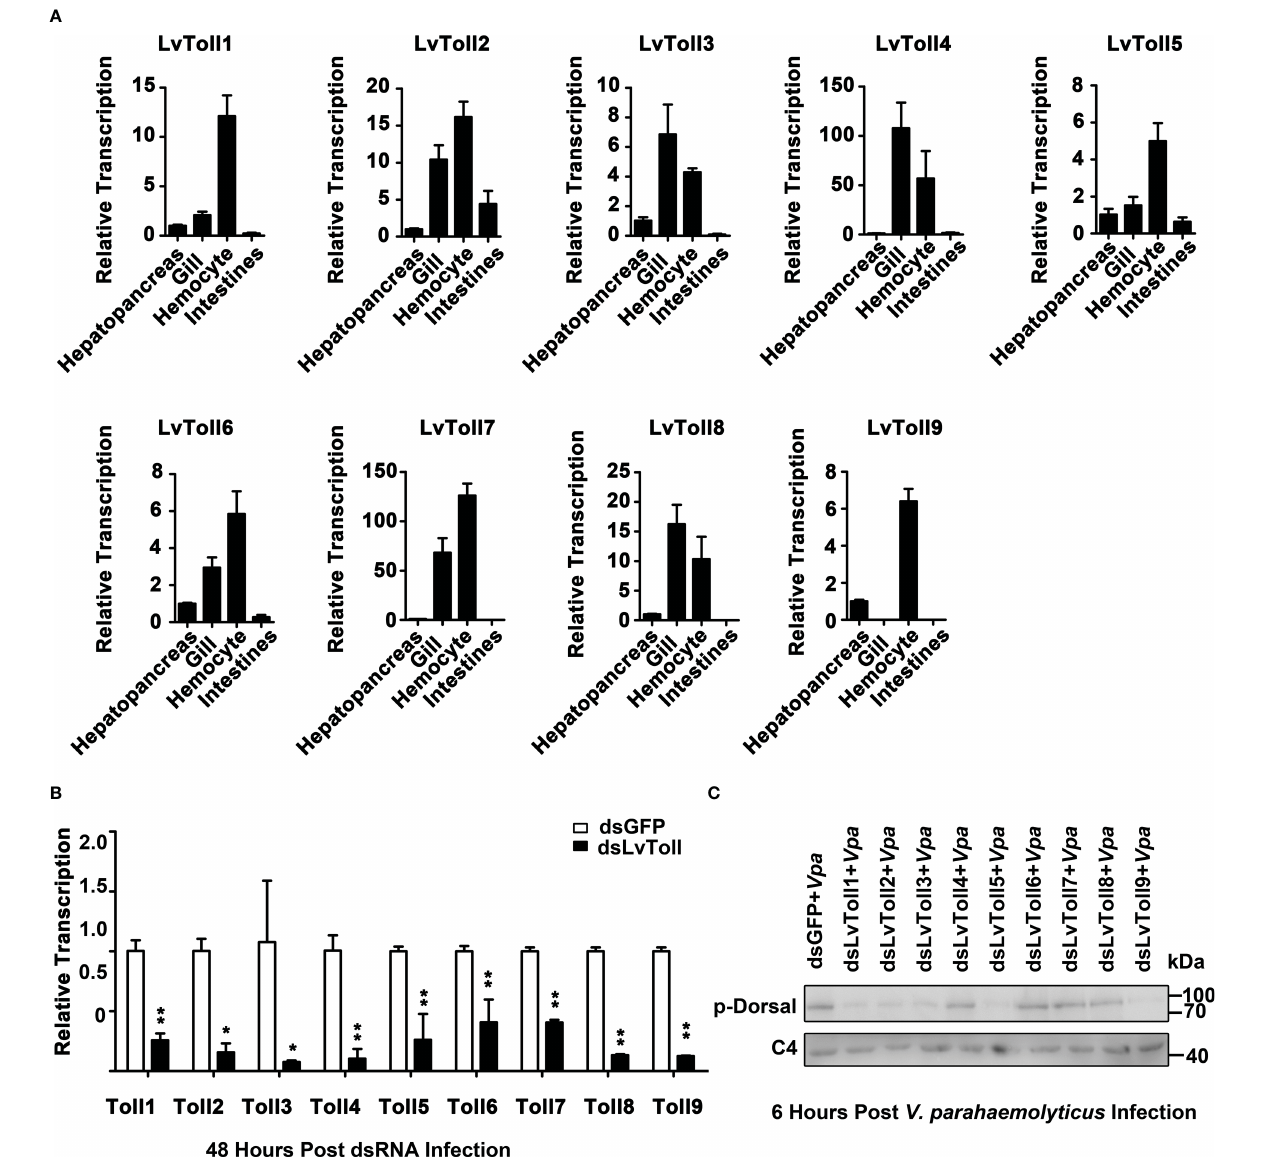
FIGURE 6 Roles of LvTolls in regulating LvDorsal-L during V. parahemolyticus infection. (A) Tissue distributions of LvToll1-LvToll9 were detected by qPCR. (B) QPCR analysis of the ef fi ciency of dsRNA-LvTolls silencing. EF1- a gene was used as internal control. (C) The phosphorylation levels of LvDorsal-L after LvTolls knocked down during V. parahemolyticus infection. The hemocytes from 3 shrimp per group were sampled for QPCR. And hemocytes from nine shrimp per group were sampled for western blotting. *p < 0.05: **p <